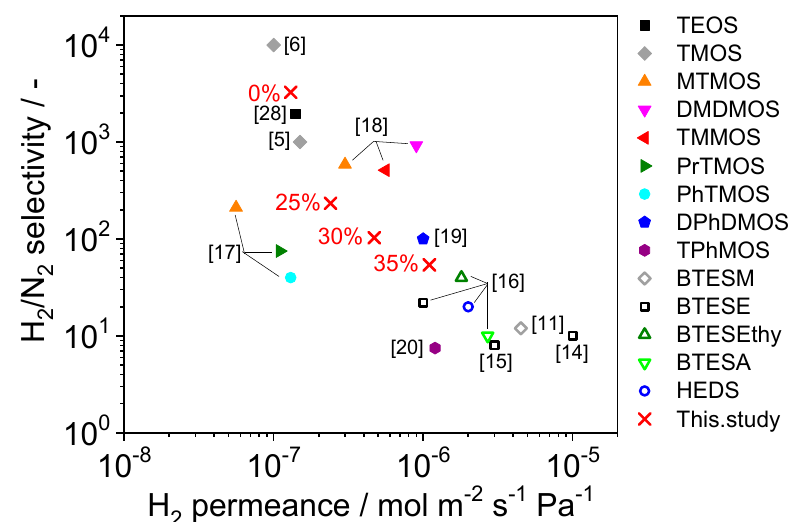
Figure 5. Comparison of H 2 /N 2 selectivity versus H 2 permeance for membranes prepared using different precursors. X : This study; open symbols: membranes prepared by the sol-gel method; closed symbols: membranes prepared by CVD. The present study was at 650 °C, sol-gel derived permeances were measured at 200 °C, DPhDMOS and TPhMOS were measured at 300 °C, TEOS and TMOS [5] were measured at 600 °C, others were measured at 500 °C (TEOS: tetraethoxyorthosilicate, TMOS: